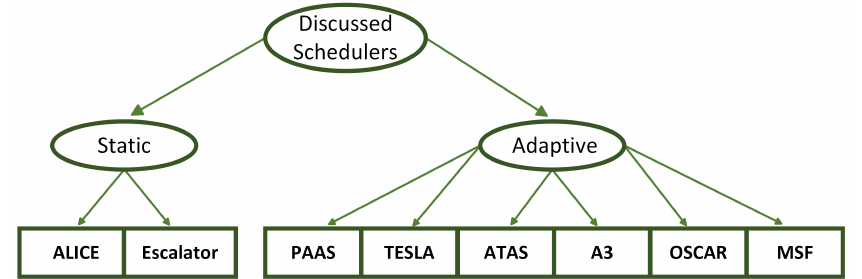
Figure 3. Overview of discussed